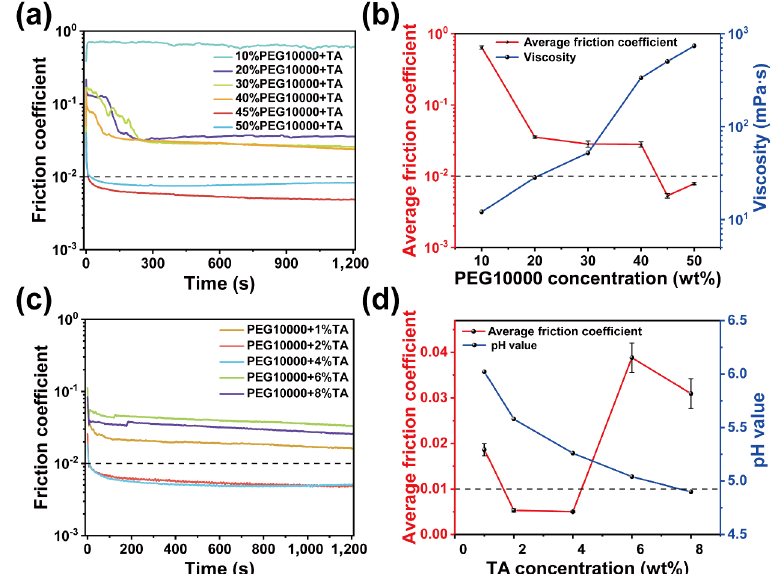
Fig. 4 For PEG10000-TA lubricant: (a) Real-time friction coefficient and (b) average friction coefficient and viscosity for different mass fractions of PEG10000; (c) real-time friction coefficient and (d) average friction coefficient and pH value for different mass fractions of TA. The load applied was 4 N, and the maximum linear velocity was 0.025 m/s.